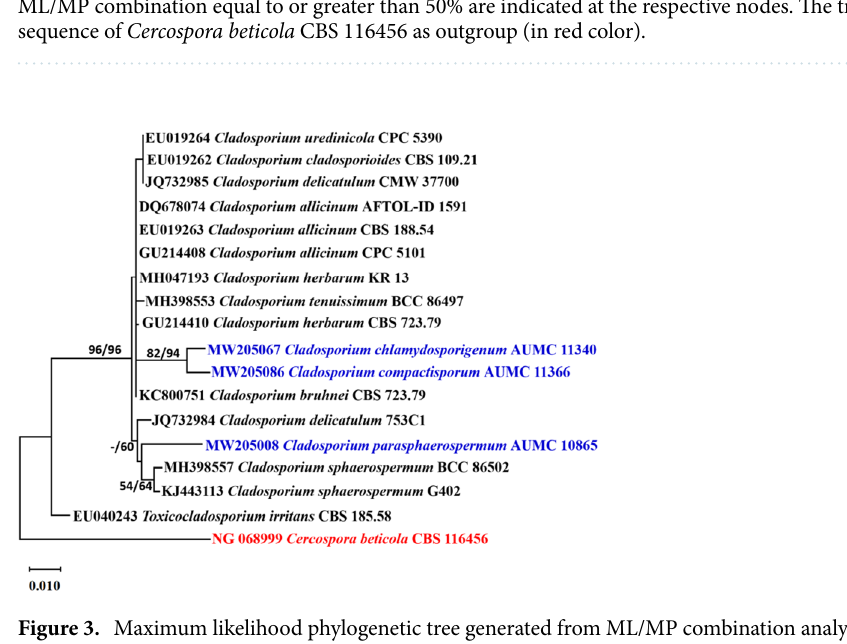
Figure 3. Maximum likelihood phylogenetic tree generated from ML/MP combination analysis based on alignment of LSU sequences of C. parasphaerospermum AUMC 10865, C. chlamydosporigenum AUMC 11340 and C. compactisporum AUMC 11366 with the most similar sequences belonging to Cladosporium in GenBank database. Sequences of species in this study are in blue color. Bootstrap support values (1000 replications) for ML/MP combination equal to or greater than 50% are indicated at the respective nodes. The tree was rooted to sequence of Cercospora beticola CBS 116456 as outgroup (in red